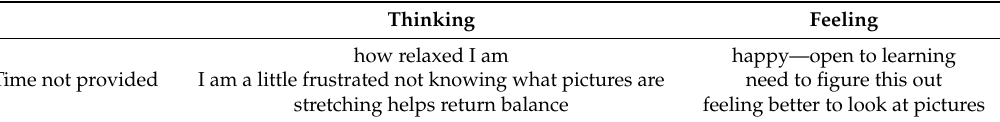
Table 3. Participant 5’s micro